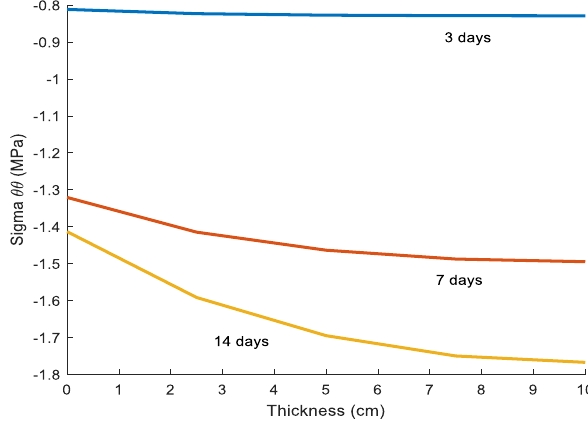
Figure 18: Hoop stress along the